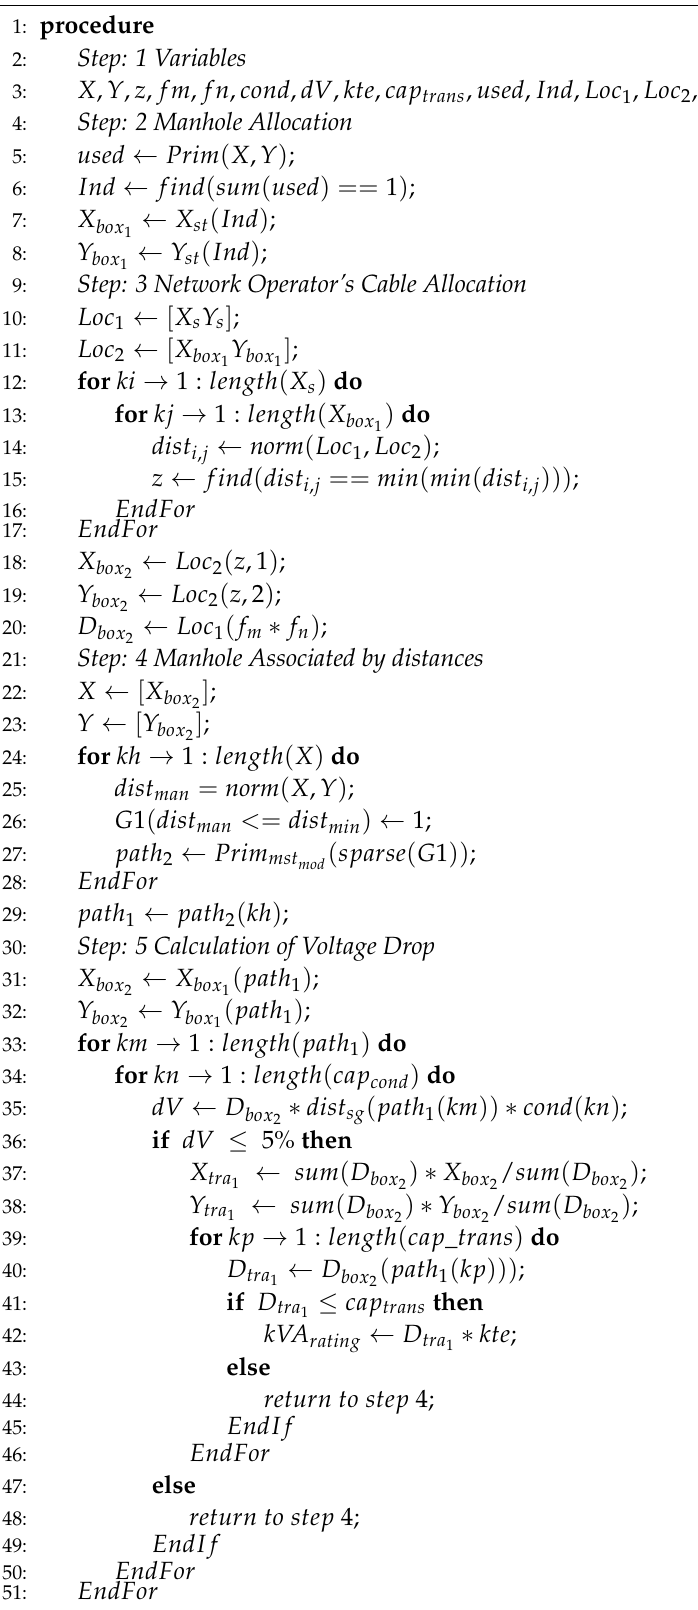
Algorithm 1 Decision-making criteria for expansion on distribution